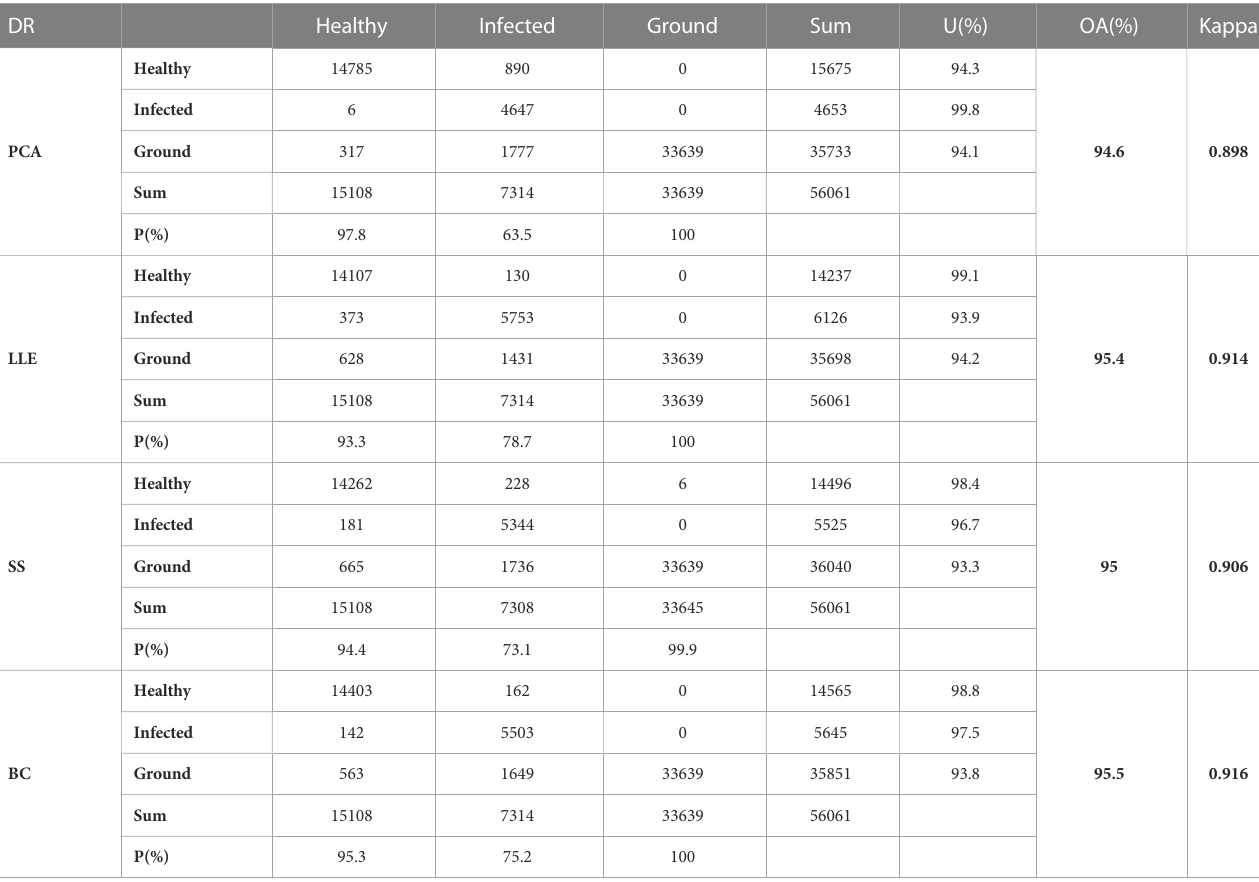
TABLE 3 Accuracy evaluation of recognition results of different spectral feature extraction methods (OA and Kappa of Table 3 is the accuracy evaluation of all recognition algorithms using some kind of dimensionality reduction). DR Healthy